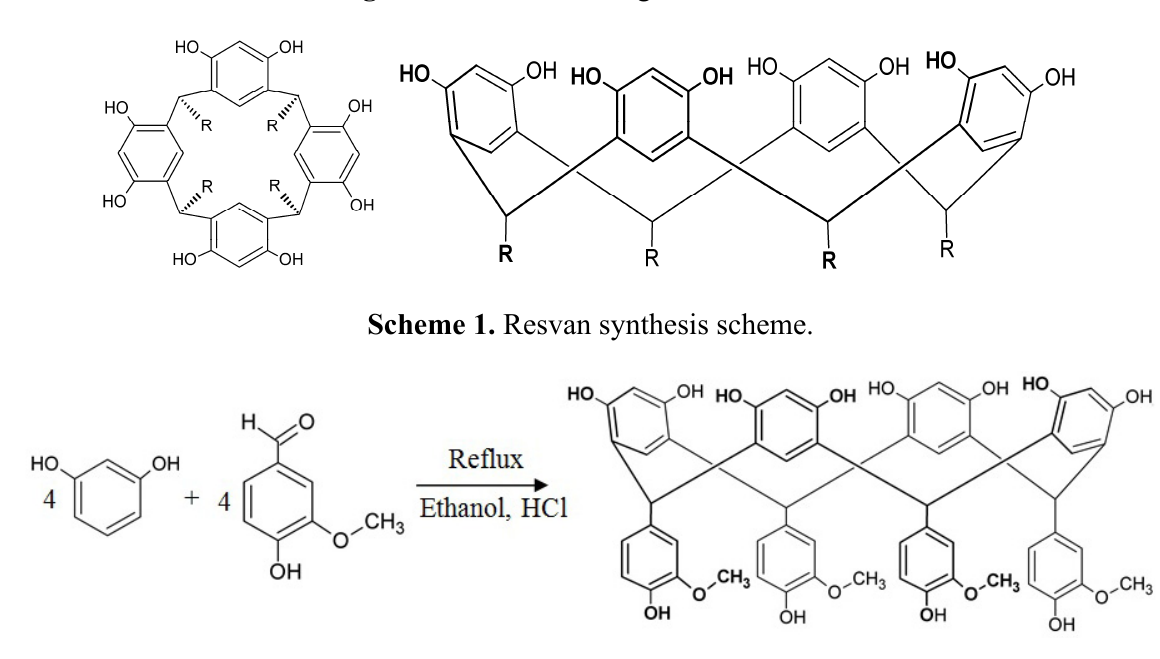
Figure 2. Resorcinarene general